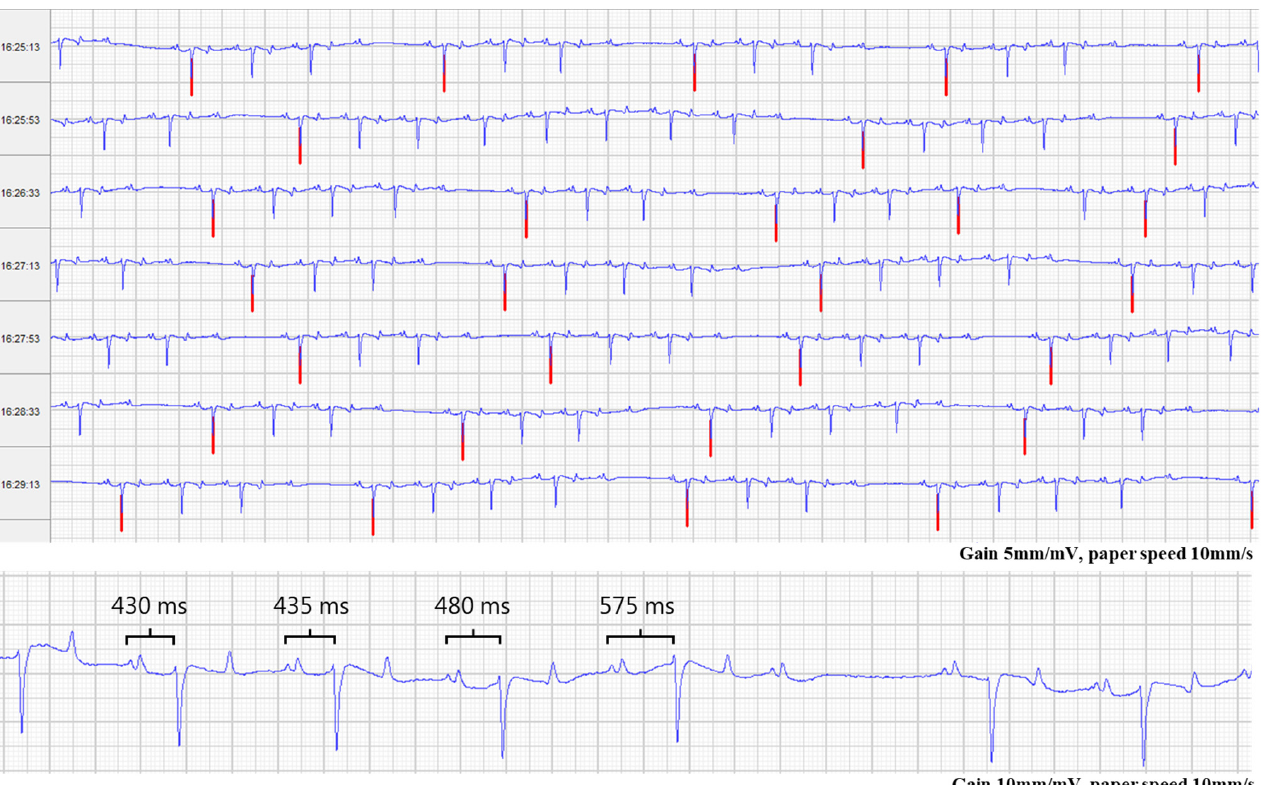
Figure 1. Resting electrocardiogram. Top: Representative electrocardiographic (ECG) strip of four minutes’ continuous recording from the 24-h resting ECG recording. Several second-degree AV blocks were present throughout most of the ECG recording often in patterns of 4:3 in P to QRS ratio. Red lines indicate post AV block beats. Bottom: The PR interval (black clamps) varied in duration prior to AV block most often showing progressive prolongation of the PR interval corresponding to the Mobitz type I block seen in humans. AV: Atrioventricular.